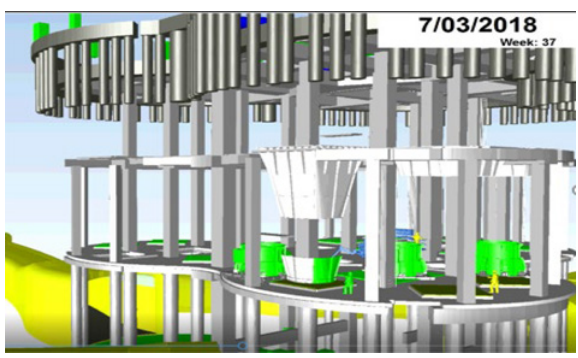
4D model created in the case study project